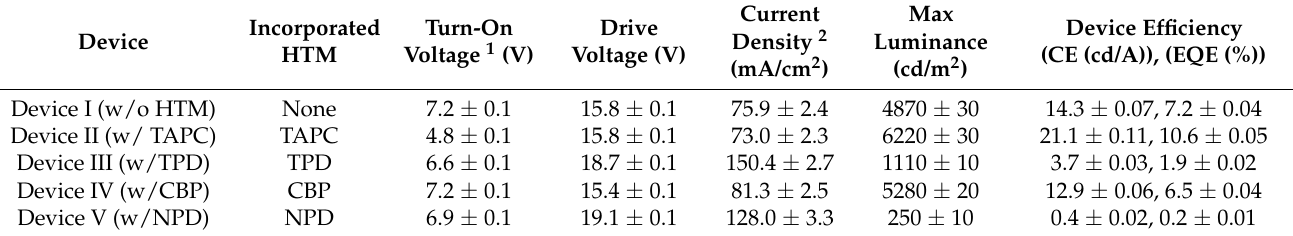
Table 1. Device characteristics of the blue phosphorescent